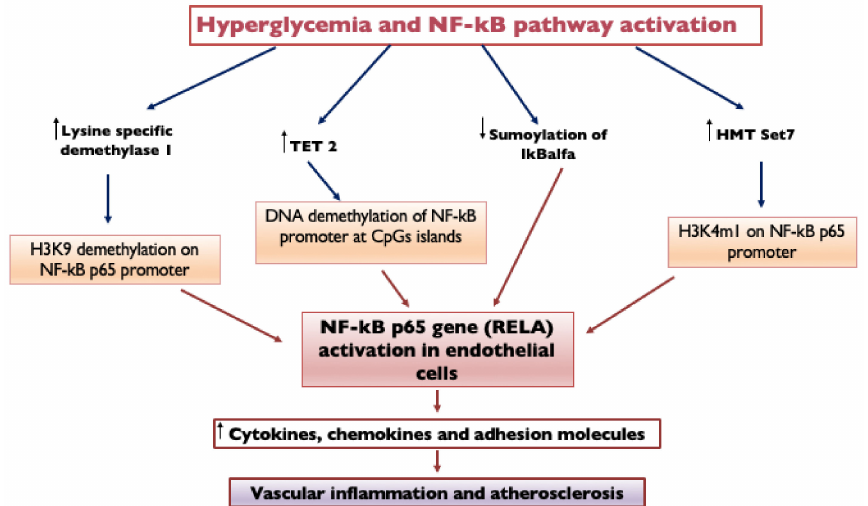
Figure 3. Hyperglycemia and NF-kB pathway activation. Endothelial cells exposed to transient hyperglycemia are characterized by the persistence of NF κ B-p65 gene (RELA) activation, induced by DNA demethylation of the NF- κ B promoter at CpGs islands through TET2 upregulation. Hy- perglycemia activates the NF- κ B-p65 gene in endothelial cells also by mono-methylation of lysine 4 on histone 3 (H3K4m1) through histone methyltransferase Set7 and demethylation of H3K9 on the p65 promoter by lysine-specific demethylase 1. Hyperglycemia also influences the SUMOylation of I kappa B α , which is the main inhibitor of NF- κ B dimers: when I κ B α is SUMOylated, it is resistant to ubiquitin-induced degradation, and it inhibits NF- κ B; in high glucose conditions, SUMOylation of I kappa B α is decreased, with consequent activation of the NF- κ B pathway. NF- κ B upregulation leads to increasing its gene targets, causing vascular inflammation and atherosclerosis. NF-kB, Nuclear Factor κ B; TET2, Ten-eleven translocation 2; I κ B α , nuclear factor of kappa light polypeptide gene enhancer in B-cells inhibitor alpha; HMT, Histone lysine methyltransferase; H3K9 demethylation, Demethylation of Histone H3 at Lysine 9; and H3K4m1, Monomethylation on lysine 4 of histone